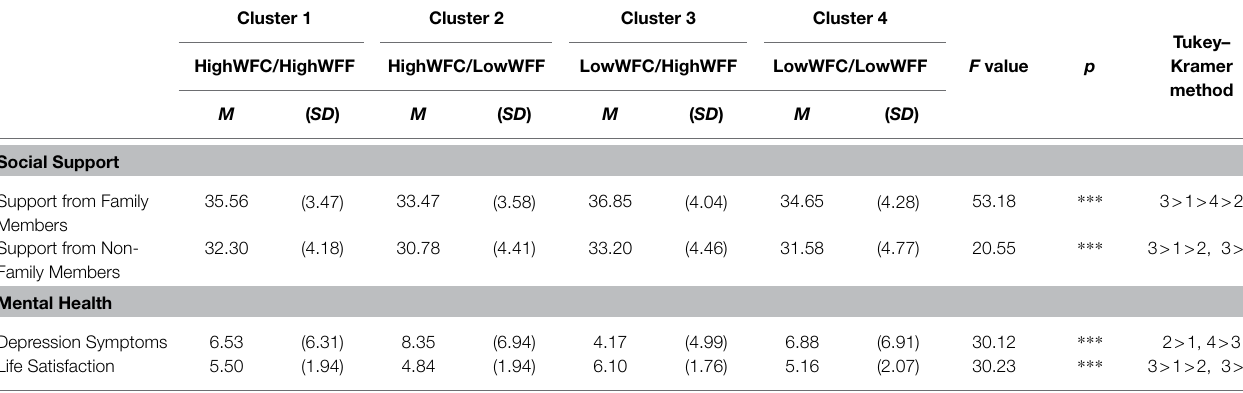
TABLE 3 | Social support and mental health across work–family balance clusters. Cluster